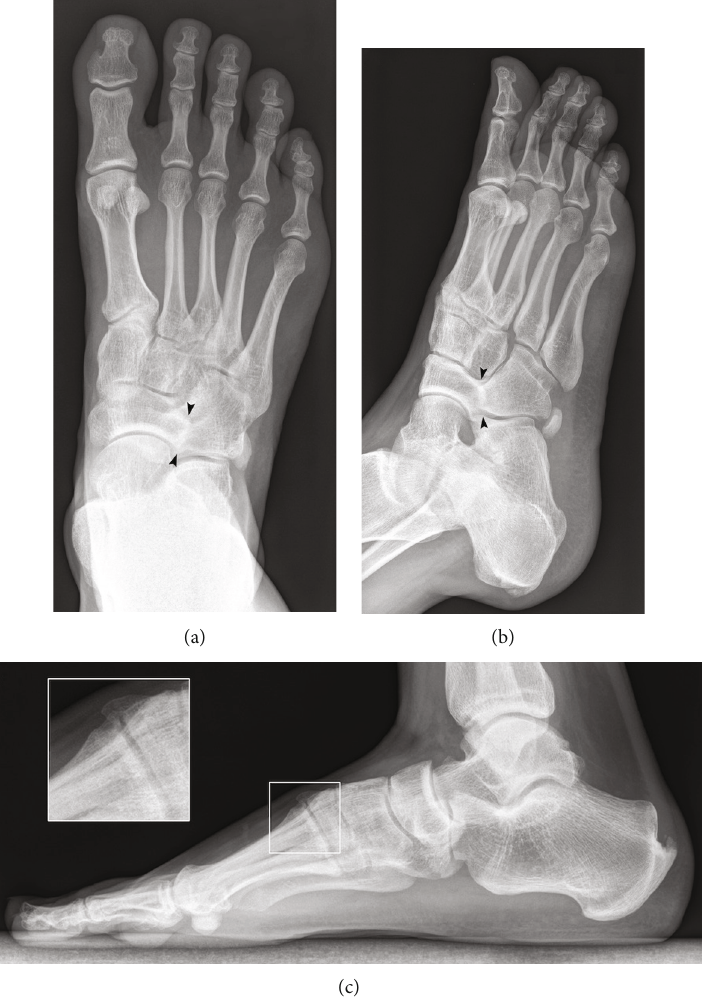
Figure 1: Frontal (a) and oblique (b) x-ray image of the right foot show an osseous cubonavicular coalition (arrowheads) with an absence of joint space. Lateral (c) x-ray image of the right foot shows degenerative changes with a spiky osteophytic deformation on the dorsal aspect of the fi rst tarsometatarsal joint and a joint line irregularity (side shot).